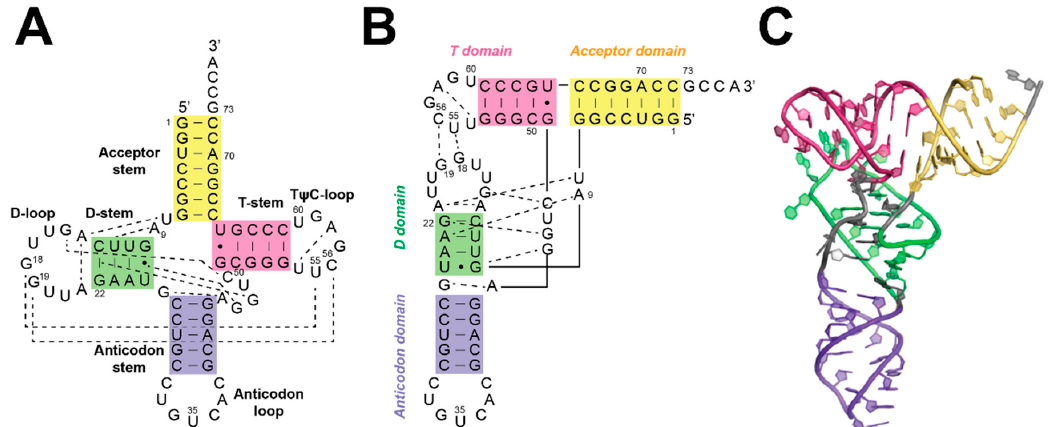
Figure 9. Secondary and tertiary structures of canonical tRNA (adapted with permission from [7]).